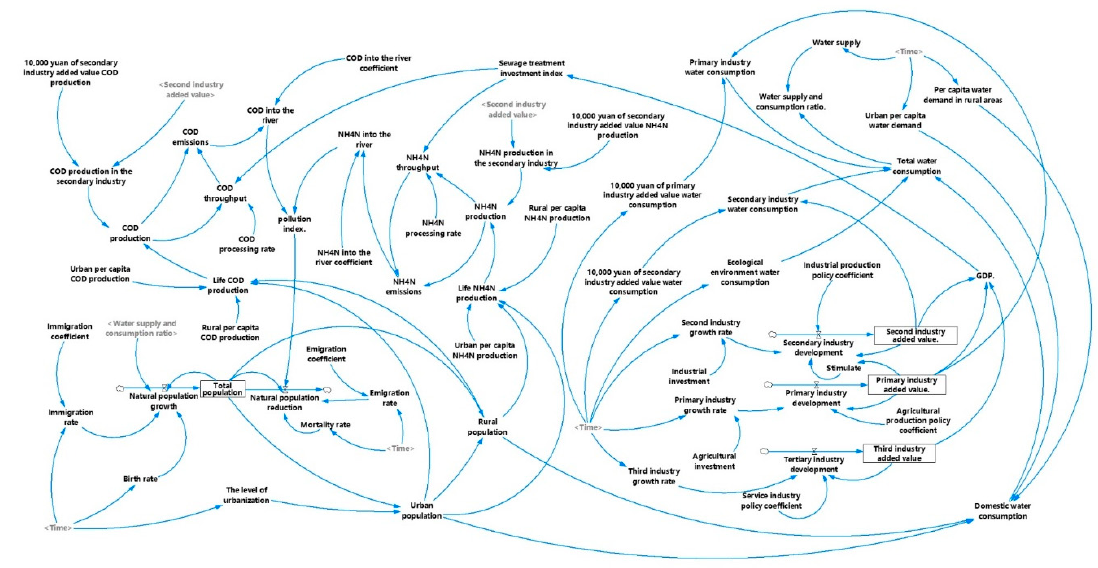
Figure 4. System dynamics flow chart of WECC in Fushun.